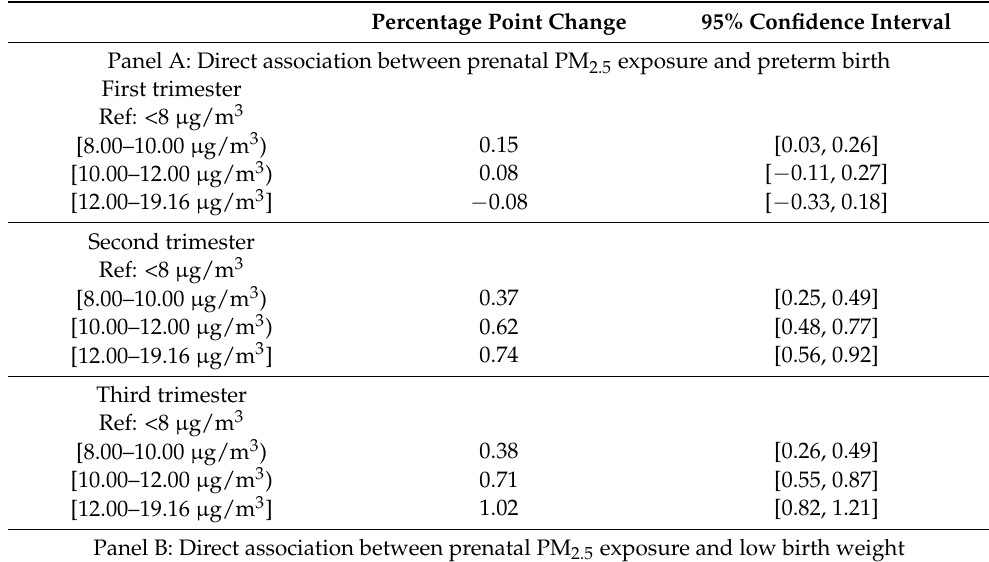
Panel B: Direct association between prenatal PM 2.5 exposure and low birth weight